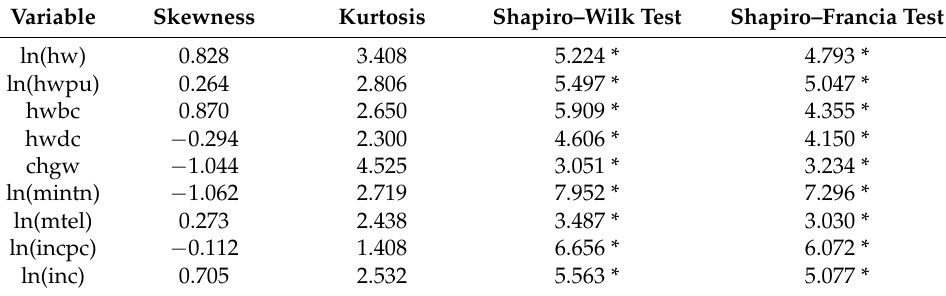
Table 3. Test results of normal